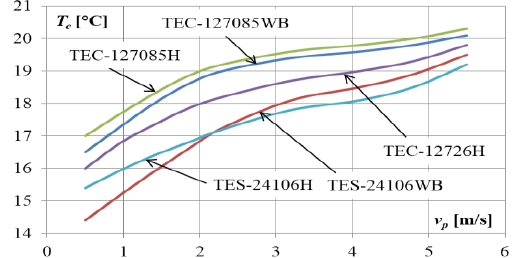
Fig. 5. Comparison of cooling capacity of exhaust air for the systems with a water block (WB) or a heat sink (H)